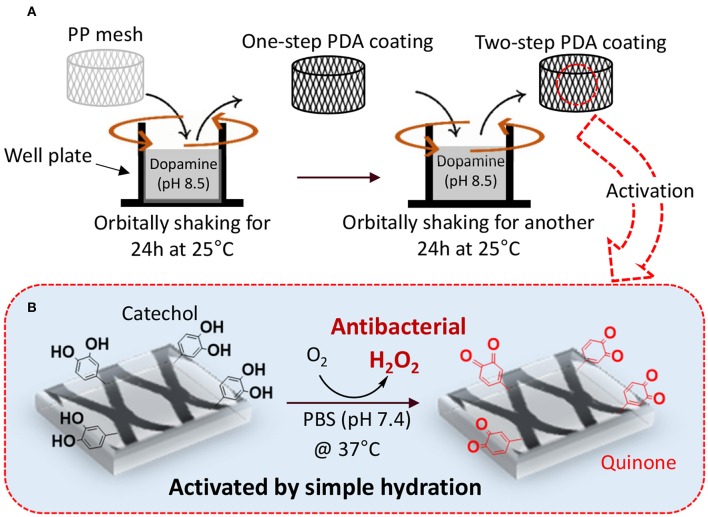
Schematic representation of two-step PDA coating with gentle shaking (A). PP mesh is immersed in concentrated dopamine solution (pH 8.5) and orbitally shaken for 24 h at 25°C to prepare one-step coating. In the second step, PDA-coated mesh is further exposed to a freshly prepared dopamine solution (pH 8.5) with reduced concentration and incubating for another 24 h at 25°C. The PDA-coated mesh contains catechol moieties that can be activated to generate H2O2 by simply hydrating the mesh in a PBS with neutral pH (B).